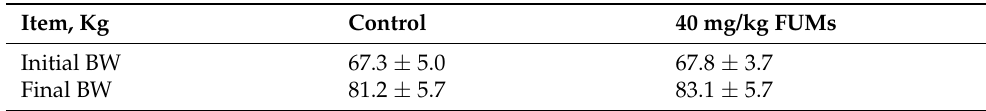
Table 4. Effect of dietary fumonisins on the growth rate of fattening pigs (data are means ± standard deviation (SD) of 5